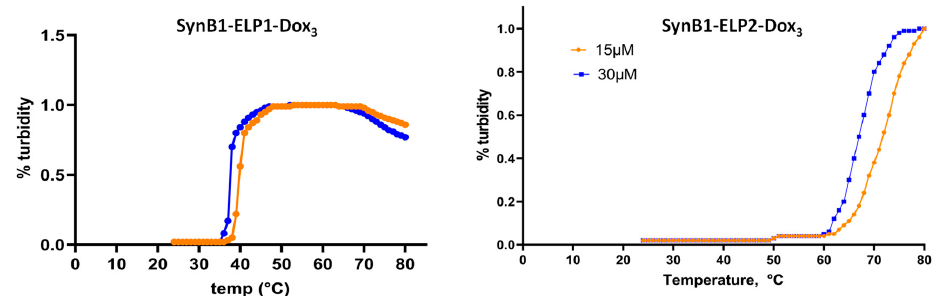
Figure 2. Phase transition of the proteins as a function of temperature. The aggregation of each protein with varying temperature was measured by the turbidity of protein solution heated at a rate of 1 ◦ C/per min and measuring absorbance at 350 nm. Rapid increases in absorbance were observed around the transition temperature of each protein.